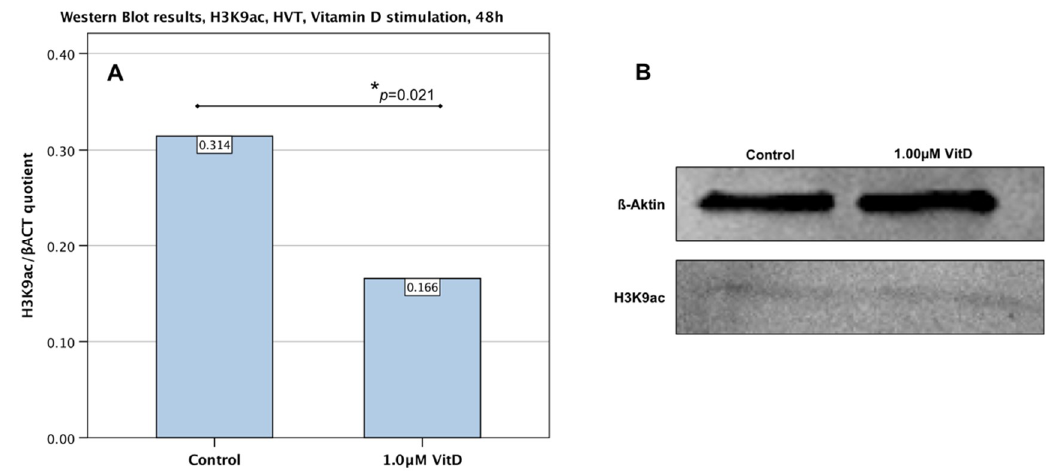
Figure 4. Western Blot analysis of H3K9ac expression in HVT cells after 48 h stimulation with human calcitriol. ( A ) Bar graph diagram showing a significant ( p = 0.03) downregulation of H3K9ac after 48 h stimulation with human calcitriol at 1.0 µ M. ( B ) Representative photograph of the western blot membrane with detected bands for H3K9 and endogenous control (β-Actin).